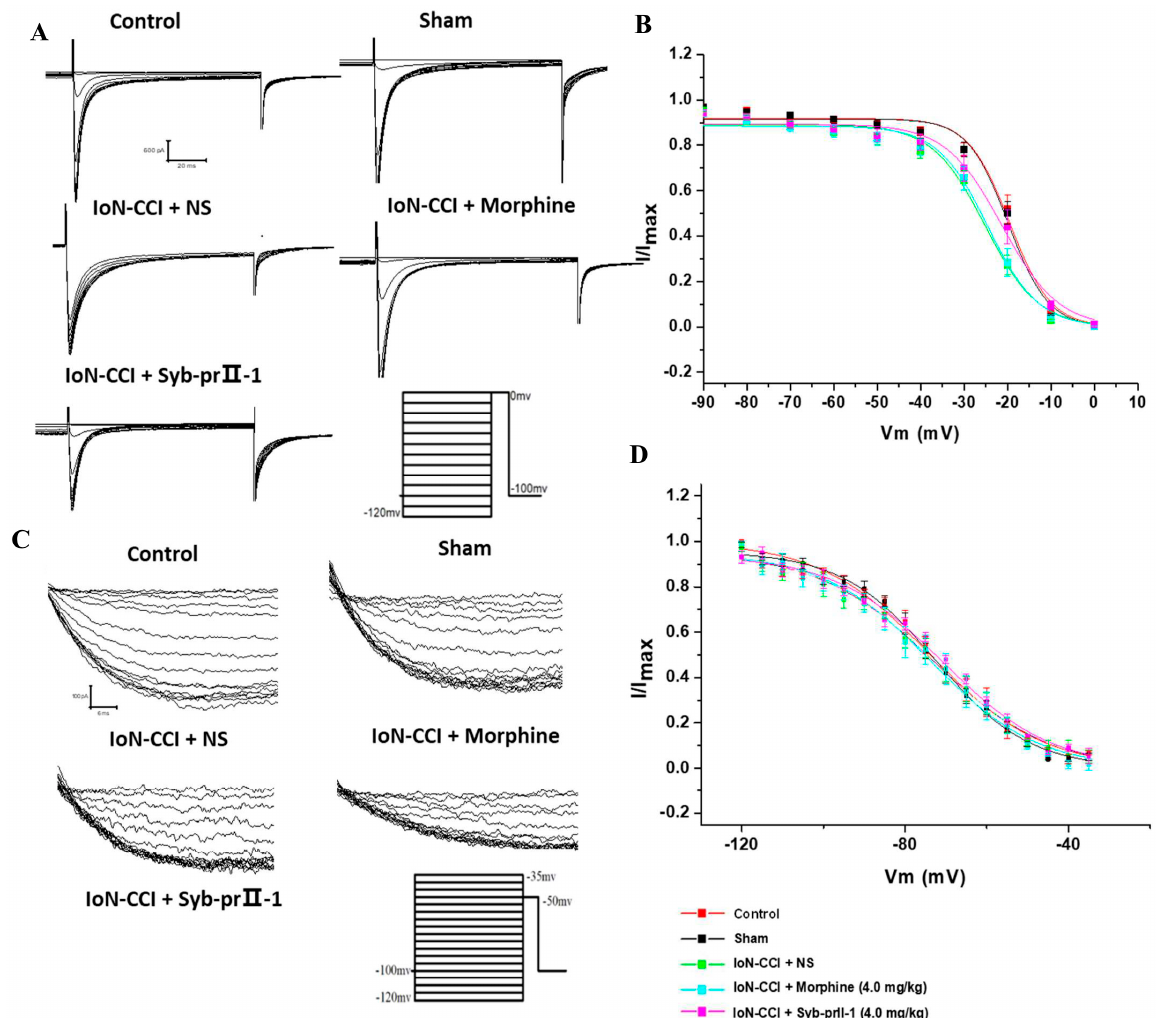
Figure 7. Effects of Syb-prII-1 on steady-state inactivation curves of Nav1.8 and Nav1.9. ( A ) Nav1.8 inactivation current was generated in 10 mV progressive steps between − 120 mV and 0 mV from a holding potential of − 100 mV. ( B ) Nav1.8 steady-state inactivation curve. IoN-CCI surgery shifted the steady-state inactivation curve in a hyperpolarizing direction; 4.0 mg/kg Syb-prII-1 shifted the steady-state inactivation curve in a depolarization direction ( n = 9). ( C ) The protocol to elicit Nav1.9 inactivation currents starting from a holding potential of − 100 mV, applying conditioning pulses ranging from − 110 mV to − 35 mV in increments of 5 mV, and applying a test pulse at − 50 mV. ( D ) Nav1.9 steady ‐ state inactivation curve IoN ‐ CCI surgery shifted the steady ‐ state inactivation curve in a hyperpolarizing direction; 4.0 mg/kg Syb ‐ pr Ⅱ ‐ 1 shifted the steady ‐ state inactivation curve in a depolarization direction ( n = 6).